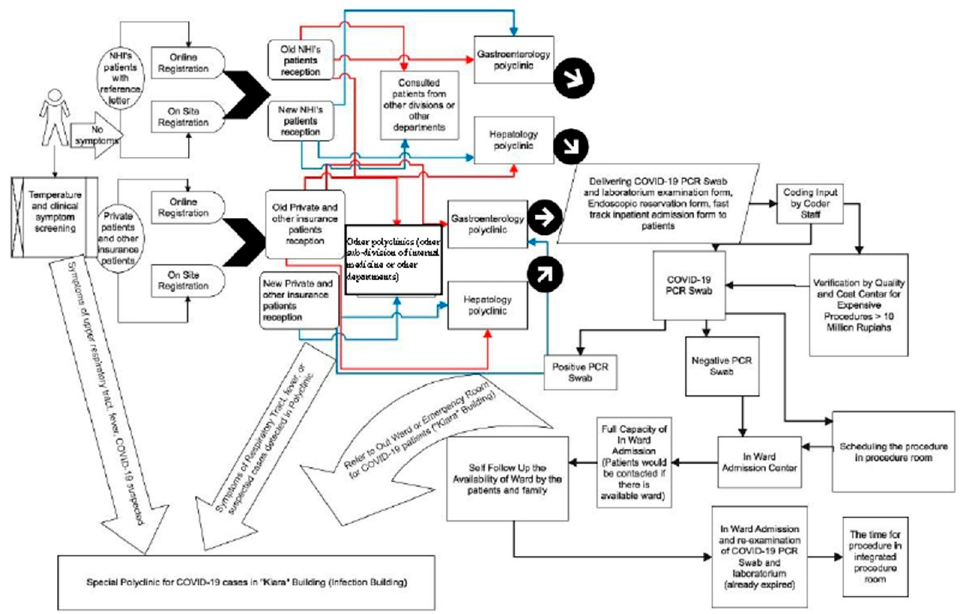
Figure 5. Entry Flow of Endoscopic Patients from Inpatient Units before the Pandemic.